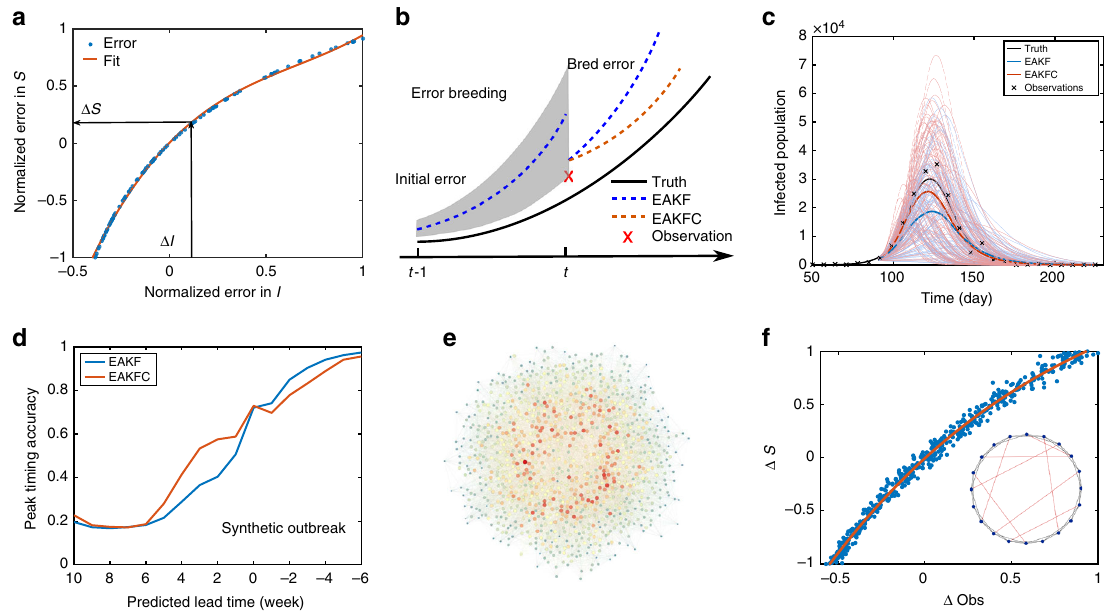
Fig. 1 Error structure in SIRS model. a Error structure between the unobserved variable S and observed variable I following perturbations imposed 3 weeks prior to peak in a synthetic outbreak ( N = 10 5 , S (0) = 0.5 N , I (0) = 1, L = 3.86 years, D = 2.27 days, R 0max = 3.79, R 0min = 0.97). The nonlinear error structure is estimated using a third-order polynomial, from which the error in S ( Δ S ) can be inferred from the discrepancy of the observed variable with the synthetic observation ( Δ I ). b Application of the breeding method to diagnose structural errors during the EAKF update. The initial random errors imposed at time t − 1 evolve per model nonlinear dynamics until time t . c An example of EAKF and EAKFC prediction at 4 weeks prior to the peak for a simulated in fl uenza outbreak. The dash lines depict the 300 ensemble predictions, while the solid lines are ensemble average trajectories. d Comparison of the fraction of EAKF and EAKFC peak timing predictions accurate within ± 1 week of the synthetic peak. The results are averaged over 10 3 SIRS-generated synthetic truths, each made with different parameters and initial conditions. For each synthetic outbreak, 100 independent predictions, each using a 300-member ensemble, are performed at each weekly observation time. e An example of an NW small-world network. f Error structure between the variable S and observation (weekly incidence) 3 weeks prior to peak in the small-world network model, fi tted by a third-order polynomial. Inset is a schematic illustration of the NW small-world network. System state is the same as in